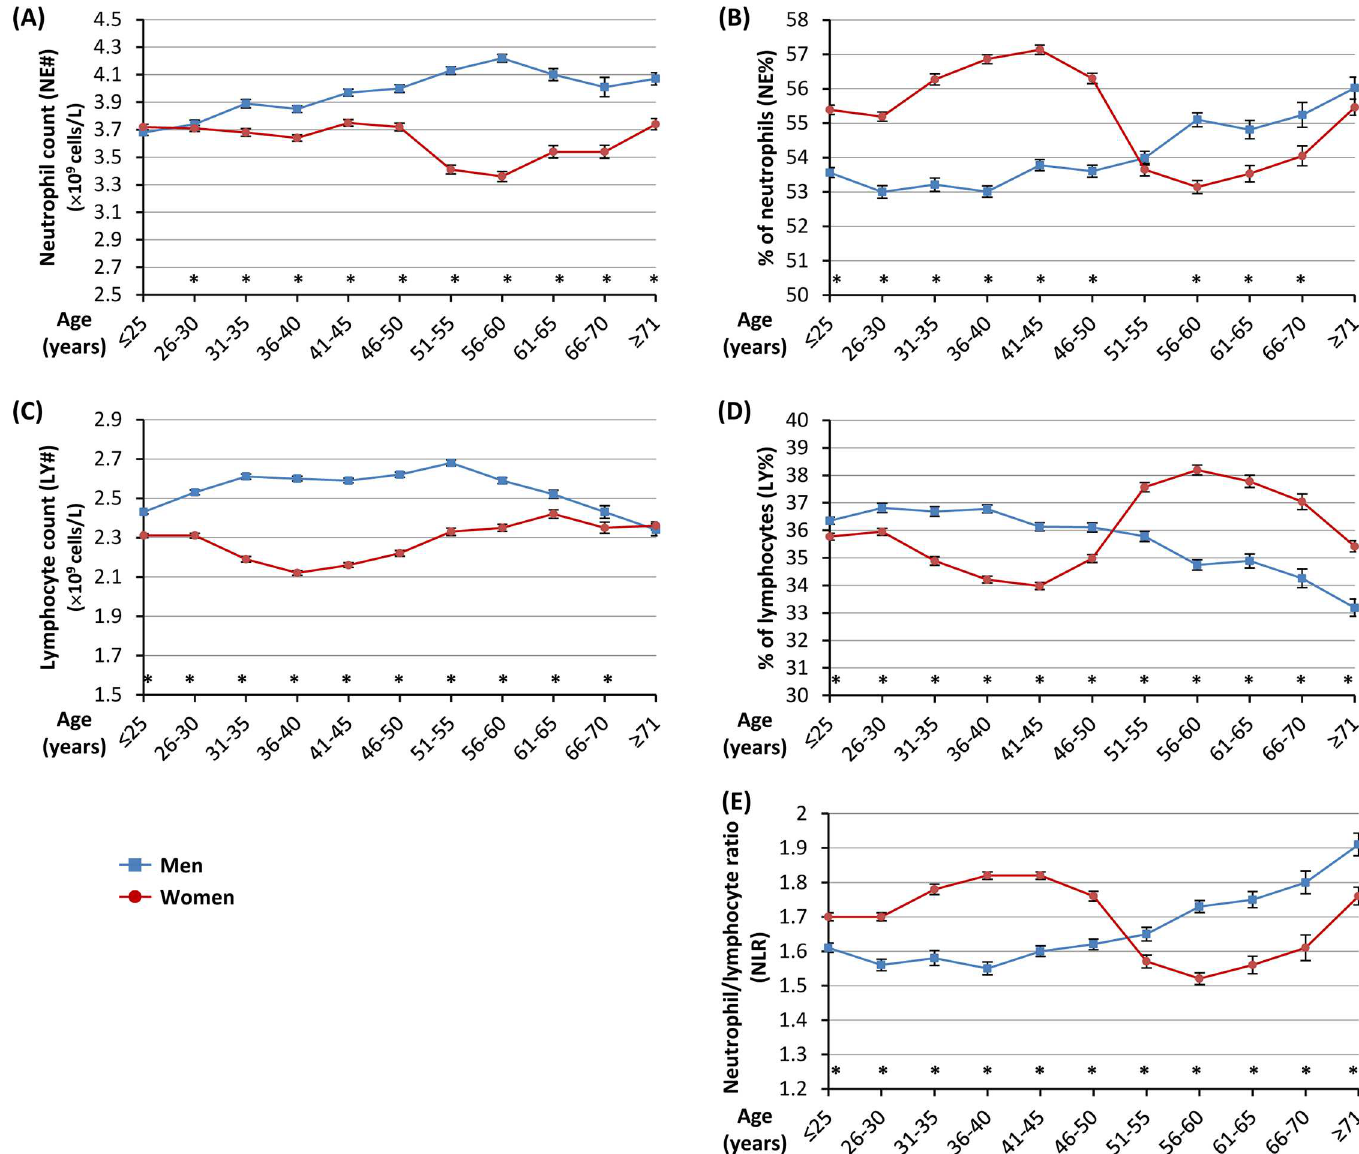
Fig 3. Counts and percentages of neutrophil and lymphocyte, and neutrophil-to-lymphocyte ratio, in men and women in different age groups. Data shown are mean ± standard error of mean in men and women, respectively, in each age group; * indicatesp < 0.05 comparingmen and women in the respective age